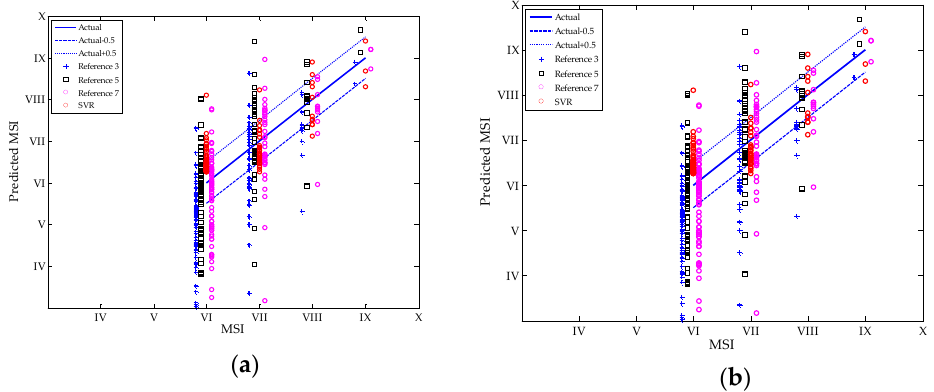
Figure 9. Performance comparison of the Gaussian kernel SVR with previous models. ( a ) Reference model based on PGA; ( b ) reference model based on PGV. Table 3. Performance measures for nonlinear SVR and linear regressions based on PGA and PGV.